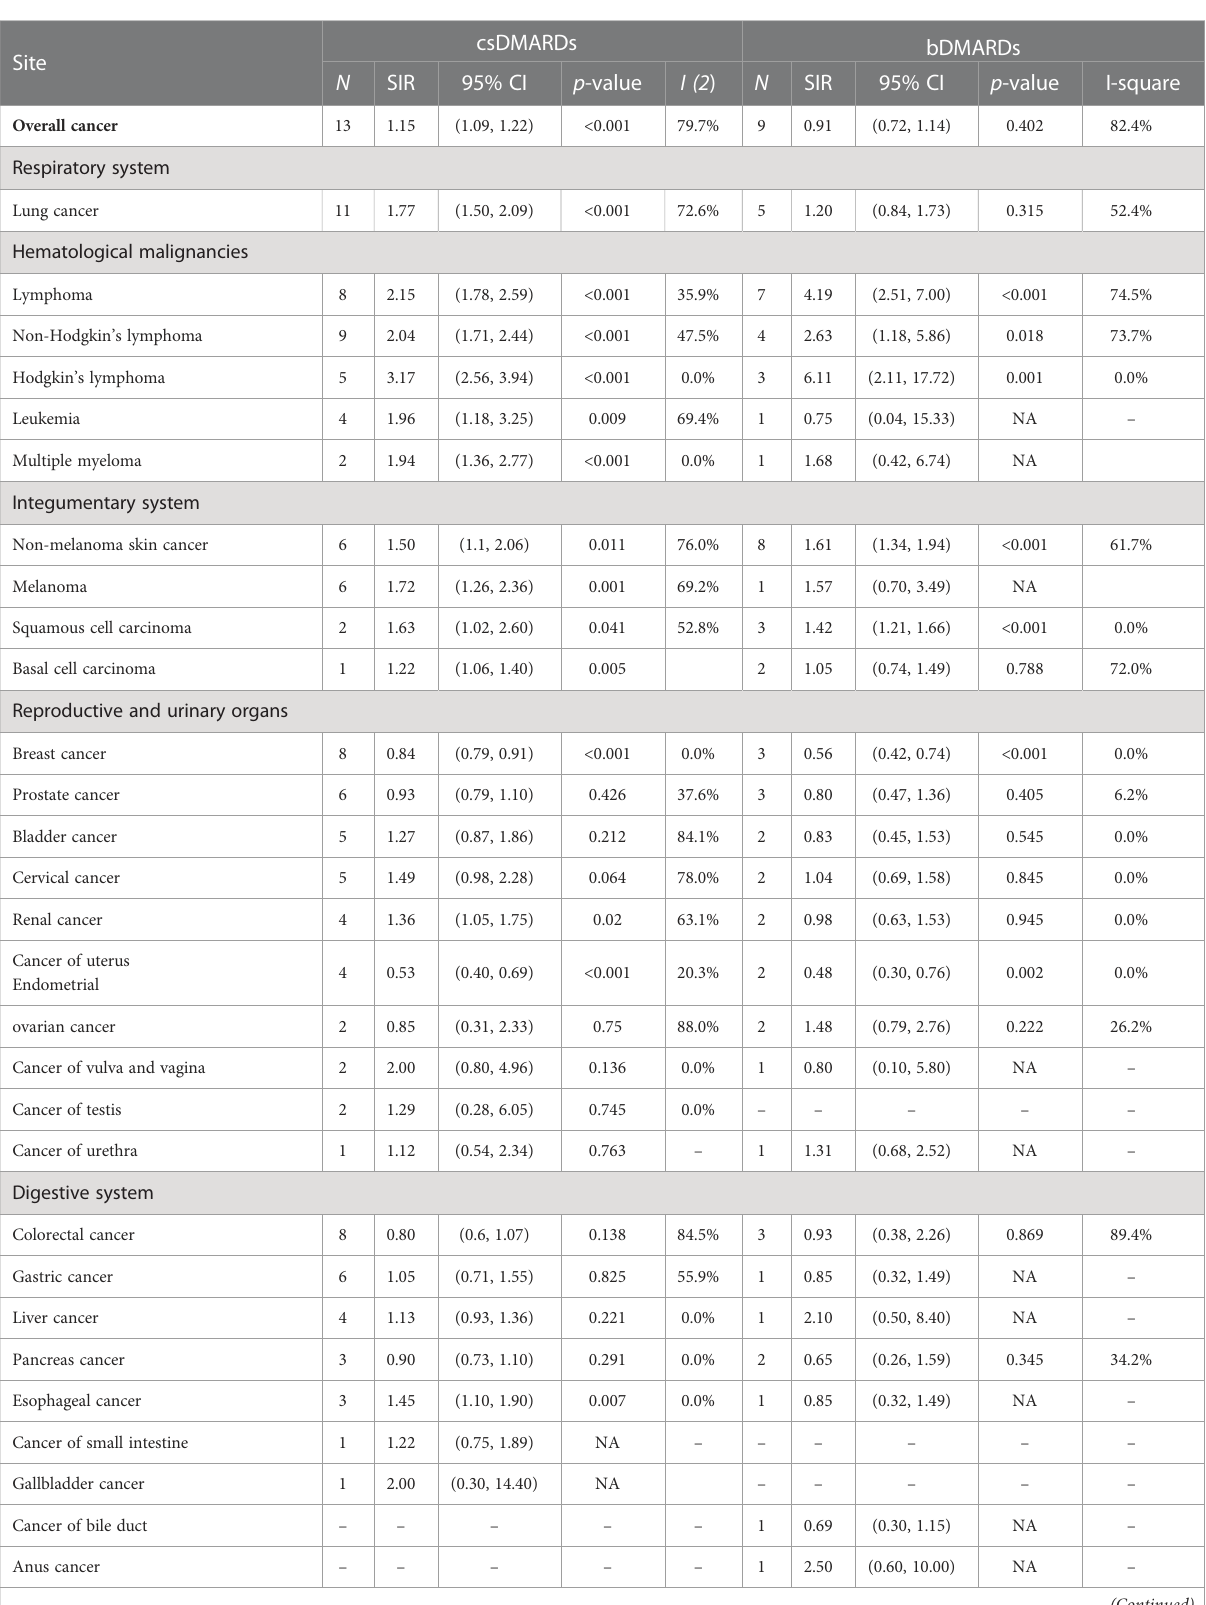
TABLE 1 SIRs of all-cancer and cancer types by anatomical site or histology among RA patients with different DMARDs.